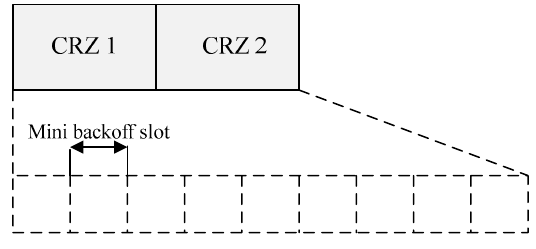
Figure 4. The structure of the proposed CRZ.